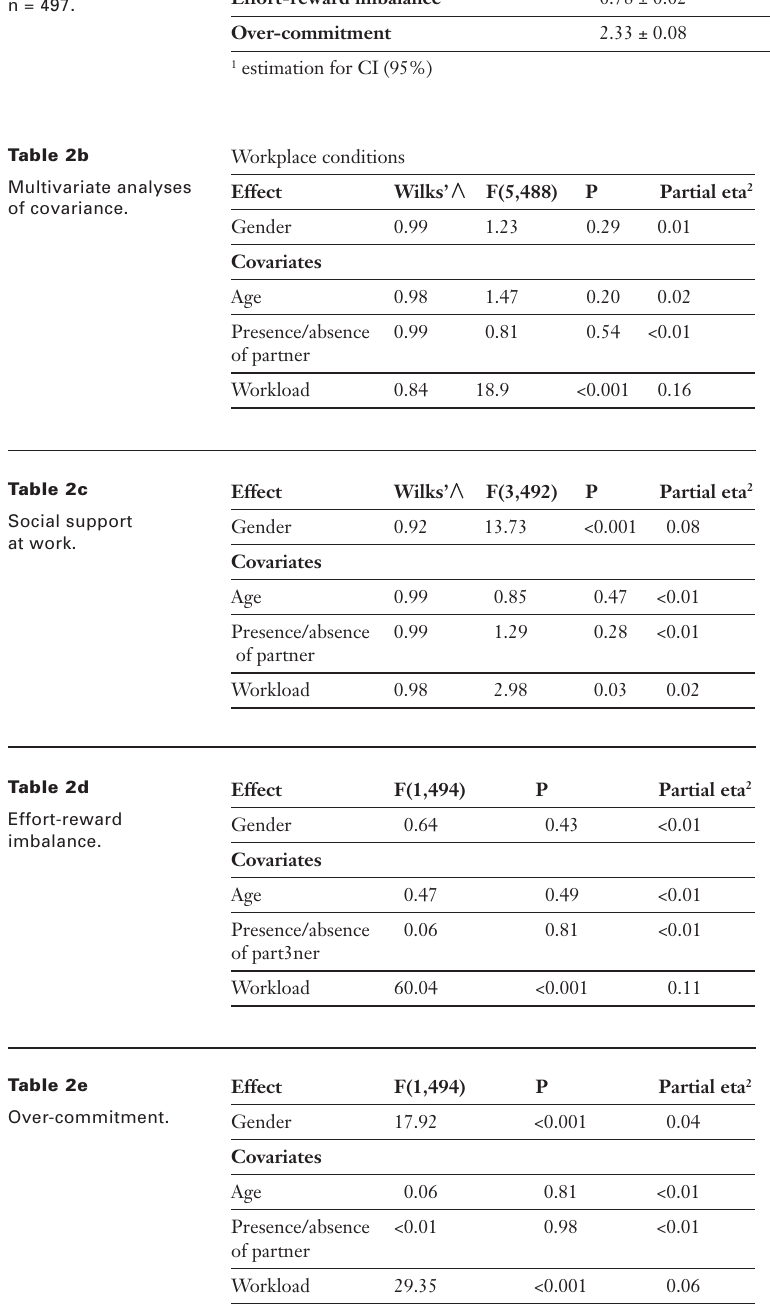
Gender-related means and Delta crit (standard error of means (SE) (cid:1) 1.96) of workplace experi- ence scales (Work- place Conditions short questionnaire, Social Support at Work questionnaire, Effort-reward imbal- ance, Over-commit- ment) and results of multivariate analyses of covariance (covari- ates: age, presence/absence of partner, workload), n = 497.